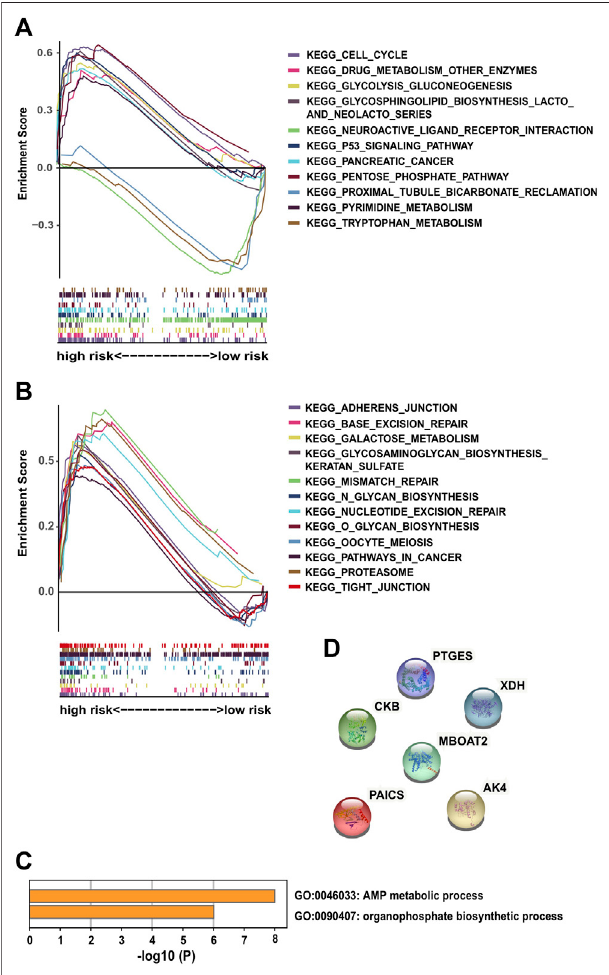
FIGURE 4 | Signi fi cantly enriched KEGG pathways in the training cohort via GSEA and molecular functional relevance analysis: (A,B) enriched pathways of the high-risk group in the training cohort. (C) Enriched terms of GO-BP among the six PDEMRGs obtained from Metascape. (D) Protein –